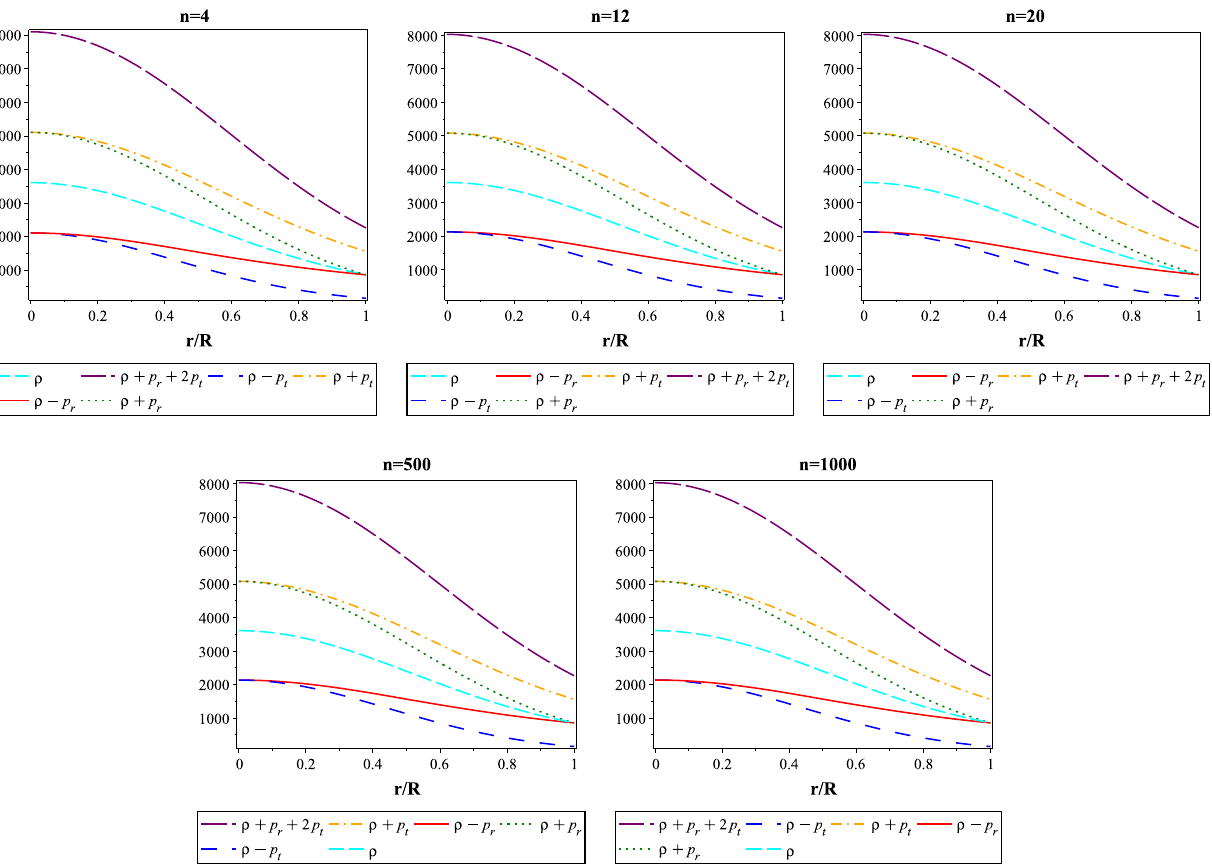
Fig. 4 Variation of the energy conditions with respect to the radial coordinate ( r / R ) for different values of n . For purpose of plotting this figure , the numerical values of the constants for different parameters n are mentioned in Table 1